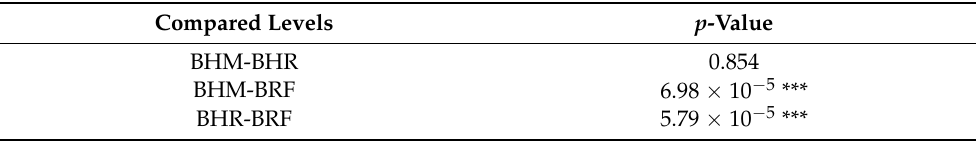
Table 7. Results of the analysis ANOVA for the breaking load.